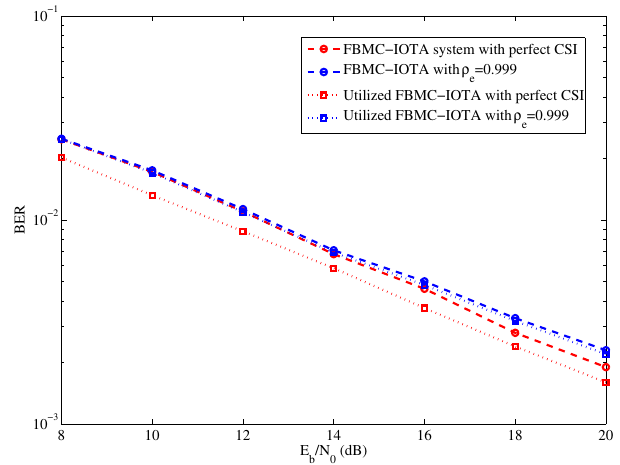
Figure 3. Effect of imperfect channel